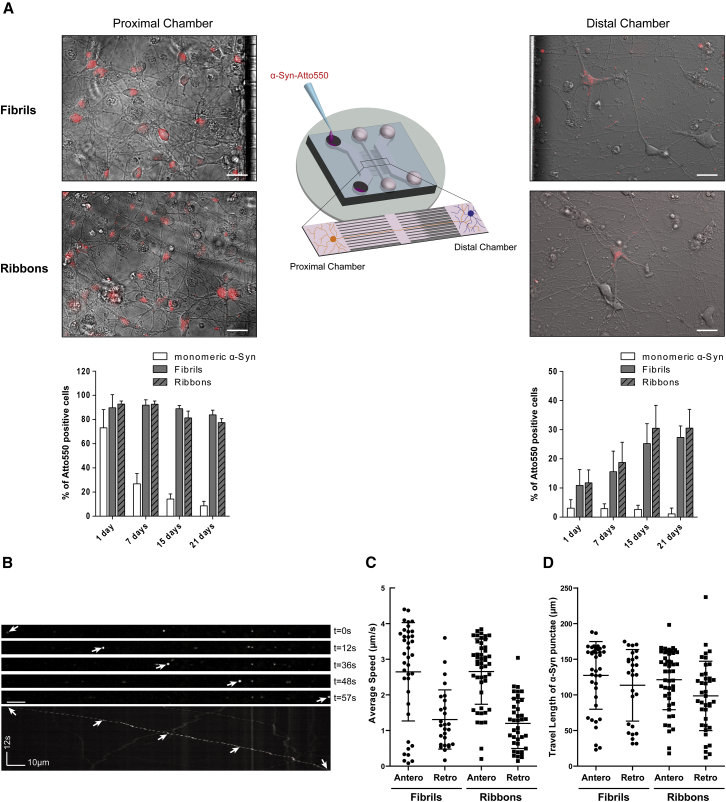
Intra-neuronal and Inter-neuronal Spreading of α-Syn Assemblies(A) Fluorescence and phase-contrast images of 30 day old corticocortical neuronal networks exposed for 24 h in the proximal chamber (left) to 500 nM Atto-550-labeled fibrils (top) or ribbons (bottom). The bar graphs show quantitative assessment of Atto-550-labeled α-Syn monomers, fibrils, and ribbons taken up by loaded neurons (left) and transferred to receiving neurons (right) at 1, 7, 15, and 21 dpe. Significant differences were observed between strains and between days post-exposure in both proximal and distal chambers (for statistical analysis see Supplemental Information). Data are shown as ± SD.(B) Kymograph analysis of α-Syn fibril movement along axons extending from the proximal chamber in a typical recording performed at 24 h post-loading.(C and D) Analysis of α-Syn assemblies' anterograde and retrograde movement in axonal tracts. (C) Average speed. (D) Travel length.Data are shown as mean ± SD. Scale bars: 25 μm.